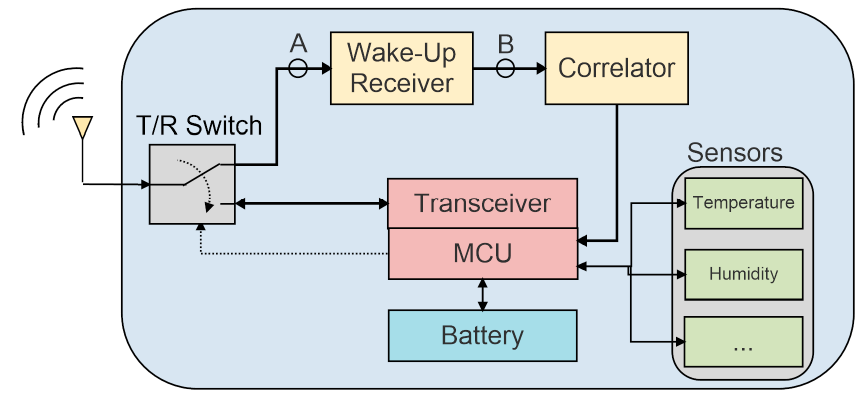
Figure 1. Block diagram of a sensor node integrating a wake-up receiver (WuR).